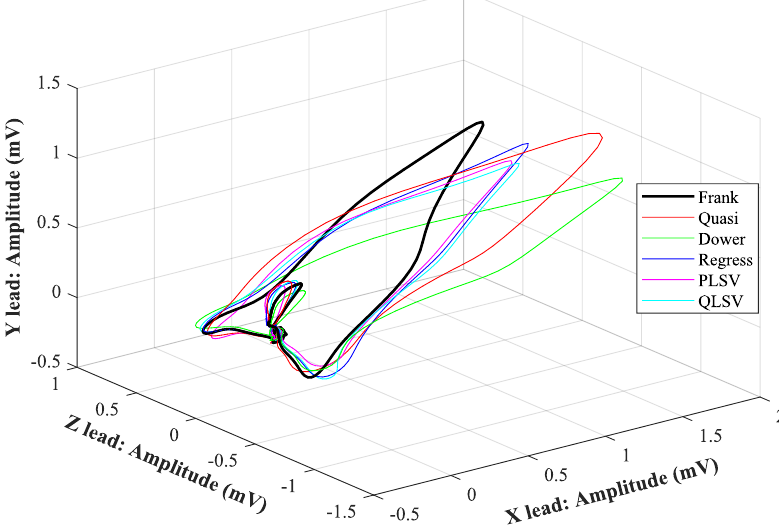
Figure 12. Comparison of transformation methods in 3-D, random patient